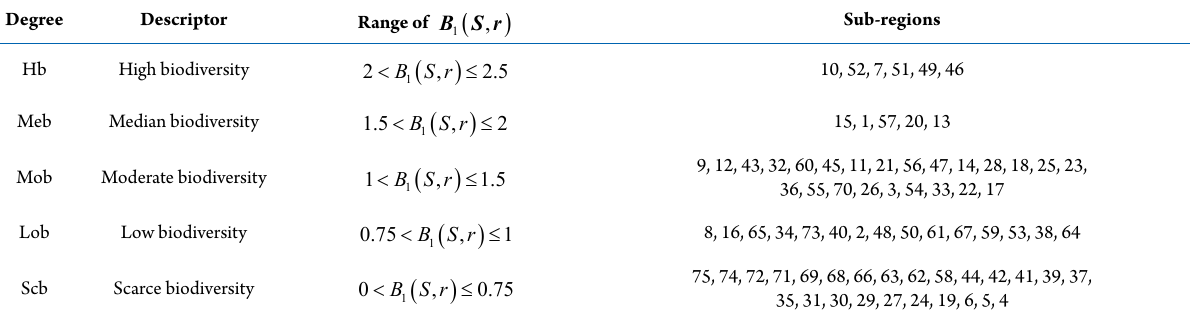
Table 3. Classification of the natural sub-regions from Colombia, on a scale of levels, according to the value of the biodiversity index. The sub-regions are identified by their codes and are listed in order of decreasing